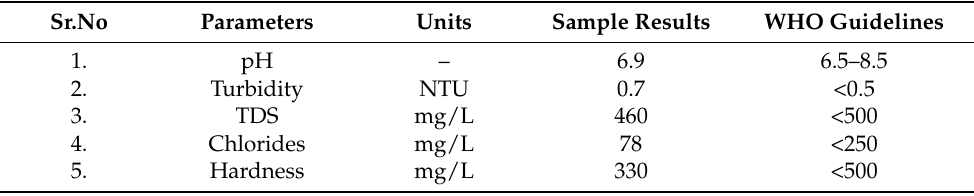
Table 4. Mixing water properties’ comparisons with World Health Organization (WHO) guidelines for potable drinking water.